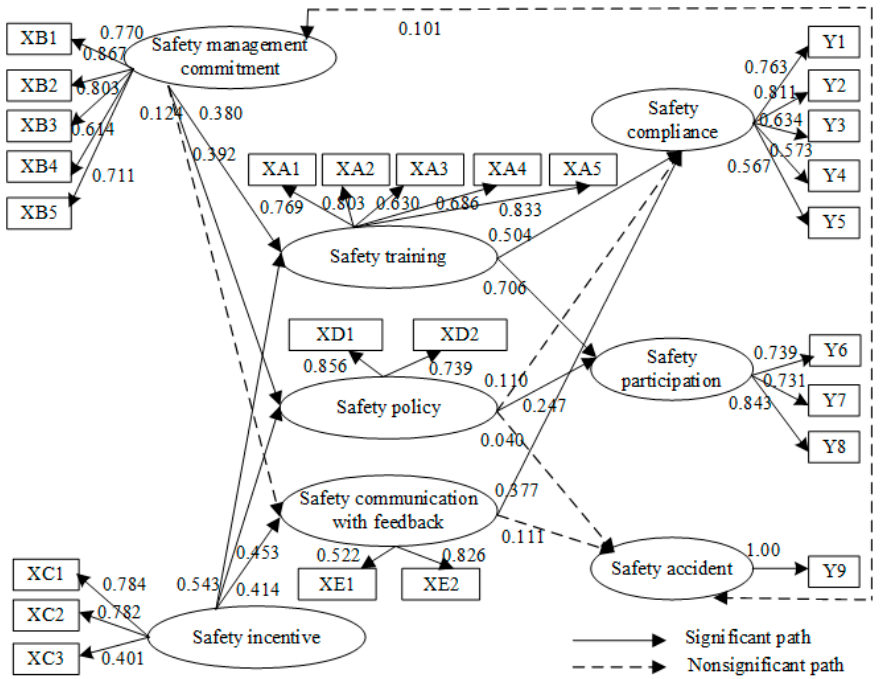
Figure 4. The revised partial mediator model of leadership behaviours’ effect on safety performance (the second model).